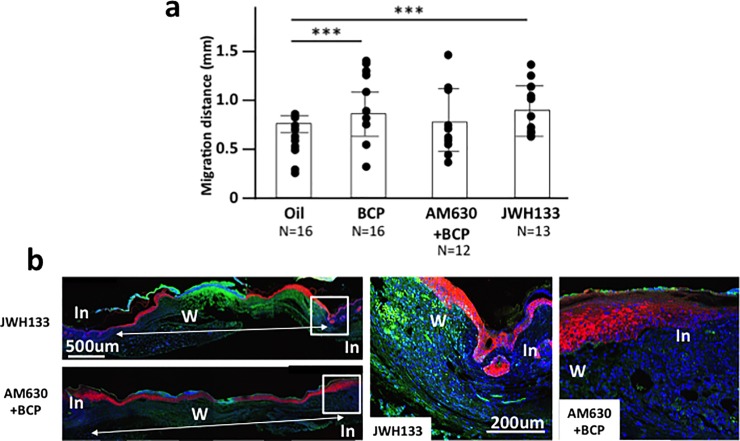
Re-epithelialization (K14+ distance from wound edge) in mice exposed to BCP, Oil, CB2 agonist JWH133, and BCP+CB2 antagonist AM633.(a) Length of K14+ staining area from the boundary of the intact and wounded area to the center of the wound in skin harvested on post-surgery day 5 from mice exposed to BCP, oil, JWH133 or injected CB2 antagonist AM630 daily before daily treatment with BCP. Dots indicate each data set and the height of bars indicates the median. Horizontal lines indicate quartiles. ANOVA, F3,53 = 5.51, P = 0.002) (ANOVA, F3,53 = 5.51, P = 0.002. Post-hoc pairwise analyses between BCP vs. oil, Tukey’s post-hoc pairwise comparison, P = 0.002, CB2 agonist JMW133 group vs. oil group, Tukey’s post-hoc pairwise comparison, P = 0.071, and CB2 antagonist AM630+BCP group vs. BCP group, Tukey’s pairwise comparison, P = 0.097; BCP, n = 9, Oil, n = 10, JWH133, n = 8, AM630+BCP, n = 7). (b) Representative images of JWH133 group and BCP+AM630 group. In: Intact area, W: wounded area.